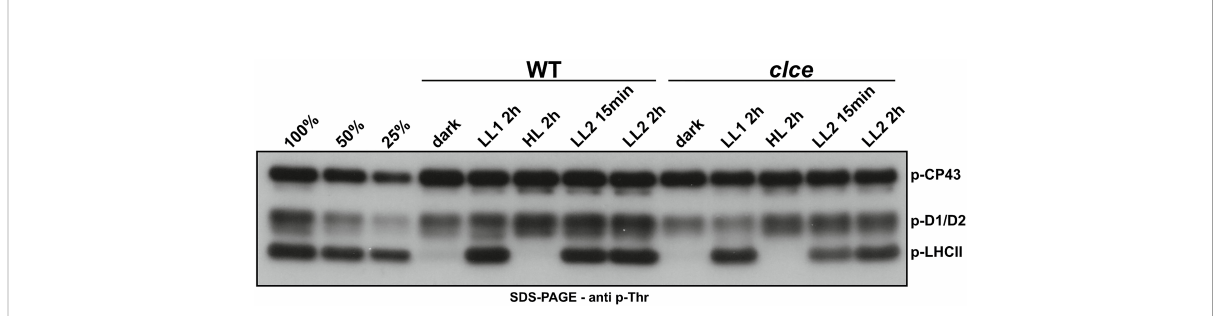
FIGURE 1 Phospho-Thr immunoblot of thylakoids from plants grown in short-day conditions. Wild-type plants (WT) and the clce mutant were grown using 8 h light (120 µmol photons m − 2 s − 1 )/16 h dark cycles for 5 weeks. Overnight dark-acclimated plants were exposed to light at 15 µmol photons m -2 s -1 (LL1) for 2 h, followed by 1000 µmol photons m -2 s -1 (HL) for 2 h and back to 15 µmol photons m -2 s -1 (LL2) for 2 h. Thylakoids were isolated from leaves harvested at the given time points and light intensities. All thylakoids were loaded on equal chlorophyll basis of 0.5 µg. 100%, 50% and 25% WT sample after LL2 2h was used as loading